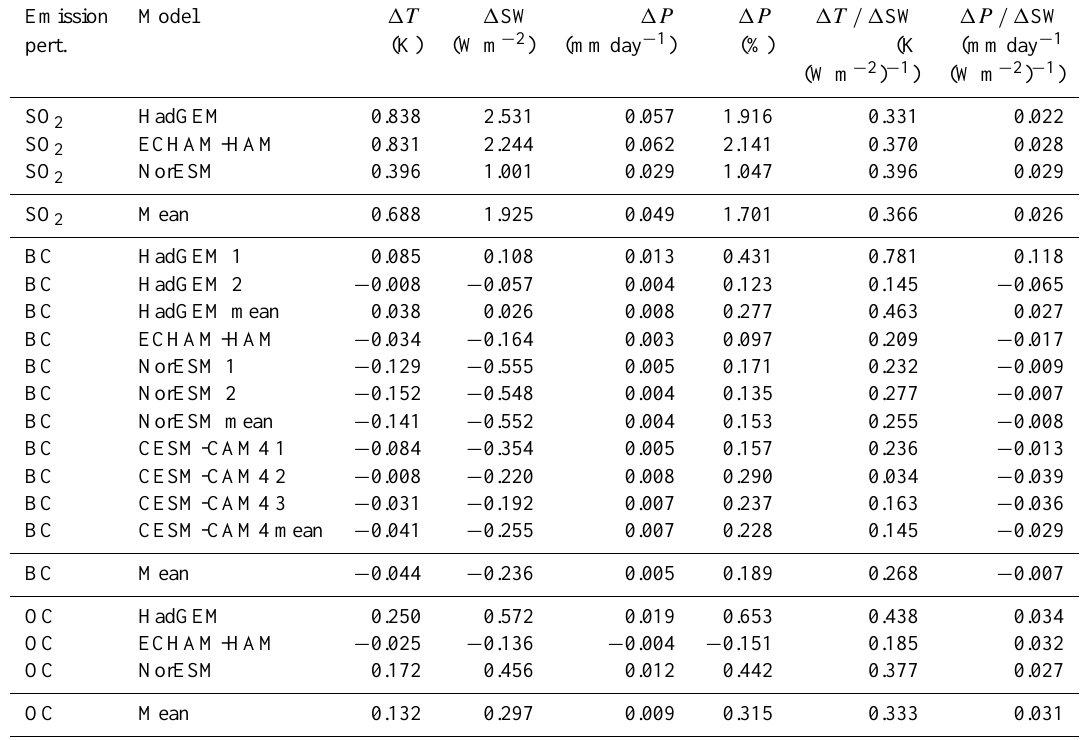
Table 2. Summary of global mean annual average climate responses. Emission